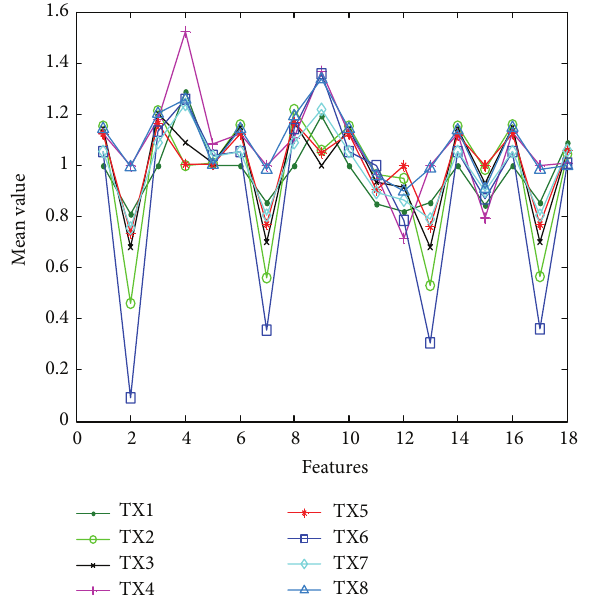
Figure 8: Averages of 18 features extracted from 100 groups of signals for 8 wireless transmitters.